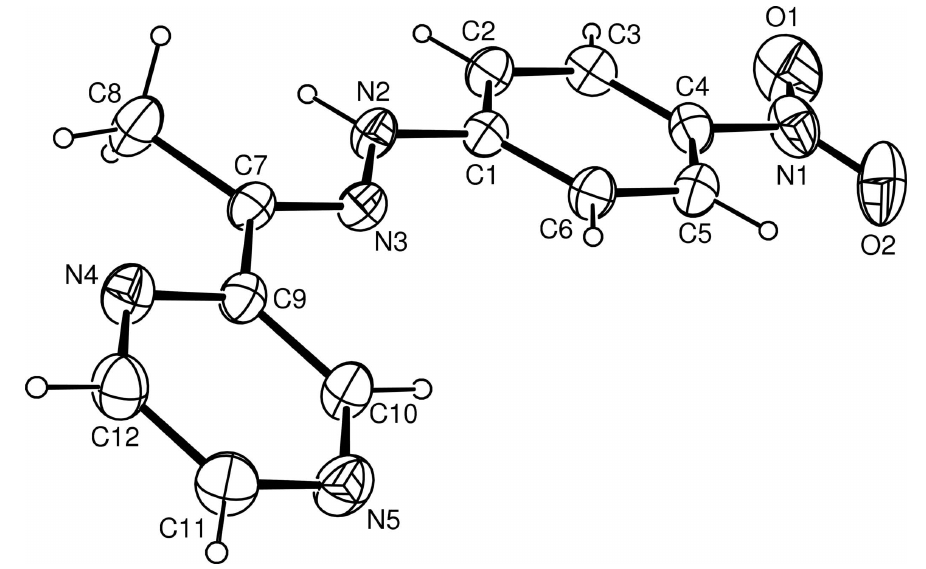
Figure 1 The molecular structure of (I) with 30% probability displacement ellipsoids (arbitrary spheres for H atoms), dashed line indicates hydrogen bonding.